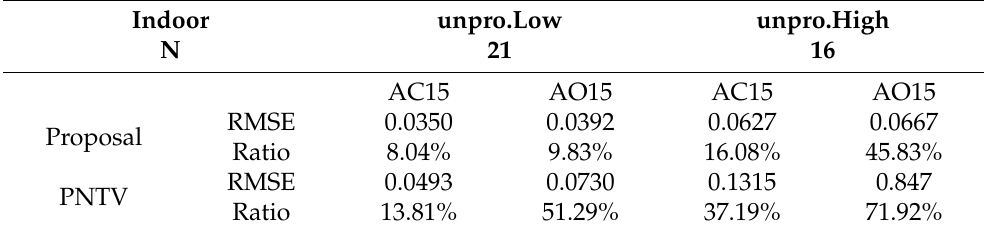
Table 2. The results of indoor wood